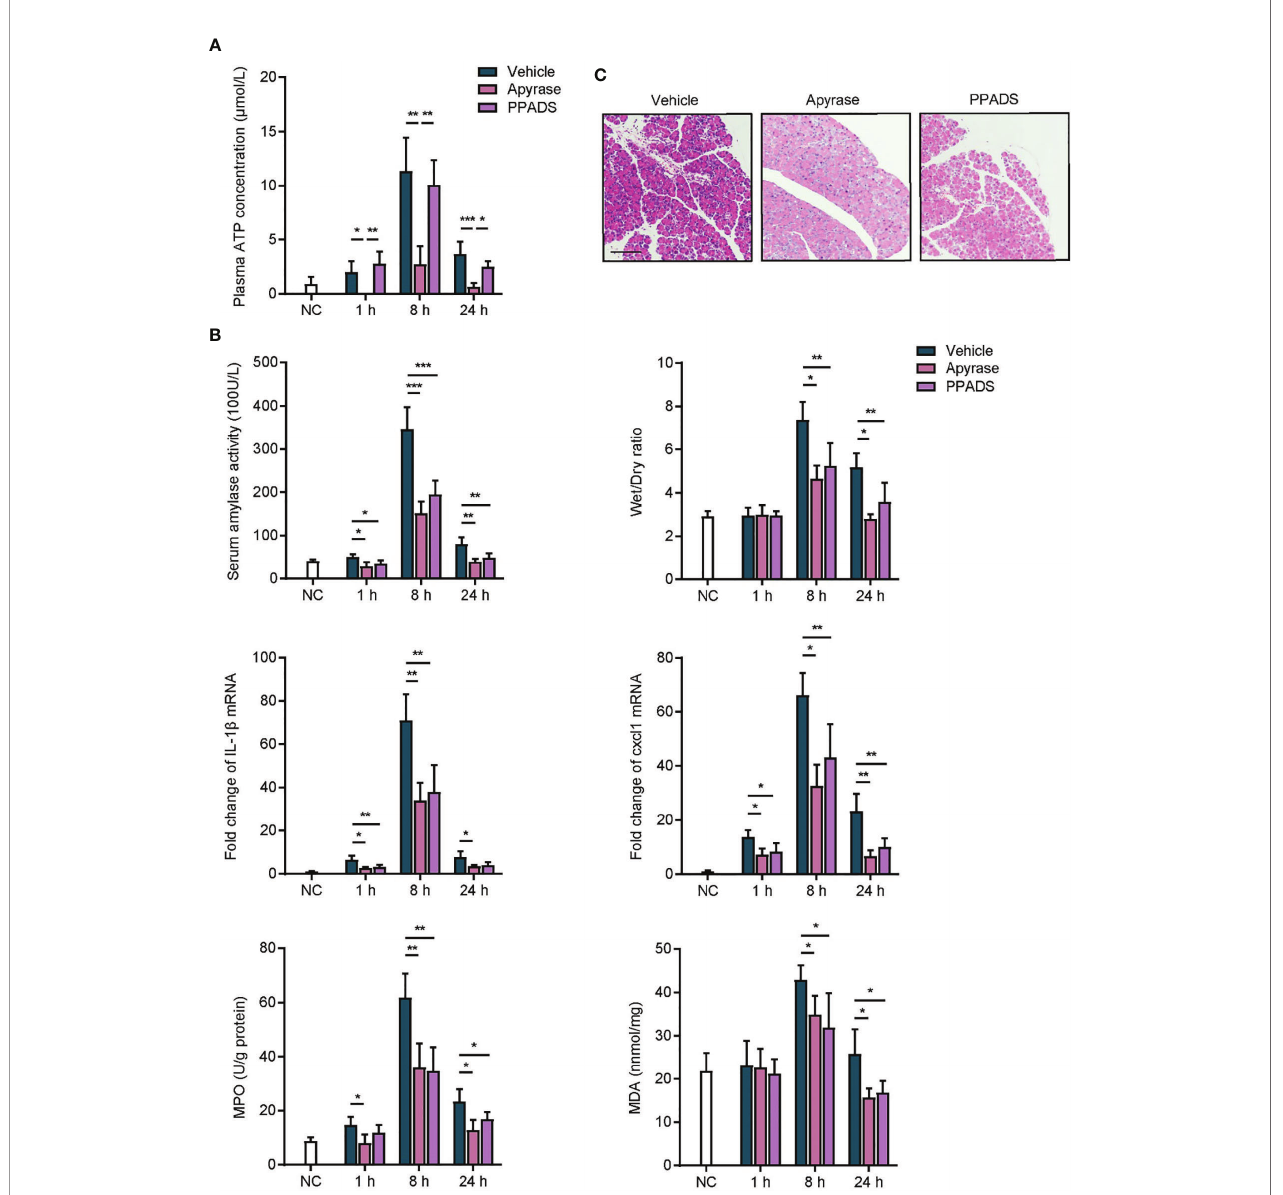
FIGURE 2 | Inhibition of purinergic signaling relieves acute pancreatitis. (A) caerulein (50 m g/kg) was intraperitoneally injected seven times hourly to induce mice acute pancreatitis. Apyrase (50 U/kg), PPADS (5 mg/kg) or vehicle was intraperitoneally injected immediately after the fi rst injection of caerulein. Saline-treated mice were set as negative control (NC). Plasma was obtained at 1, 8, and 24 h after the fi rst injection of caerulein, and ATP concentration was detected (n = 5 per group). (B) At 1, 8, and 24 h after caerulein exposure, serum amylase activity, pancreas wet/dry ratio, IL1- b mRNA expression, Cxcl1 mRNA expression, myeloperoxidase (MPO) activity, and malondialdehyde (MDA) content were analyzed to evaluate in fl ammatory status (n = 5 per group). 2 − dd Ct value was used for comparisons of the fold change of mRNA expression to NC mice. (C) Pancreas tissues from each group were harvested at 8 h, stained with H&E and observed under a microscope (100×). Representative images were shown (n = 5 per group). Scale bar is 50 m m. Statistics were calculated using one-way ANOVA with Tukey post-tests. * P < 0.05, ** P < 0.01, *** P <